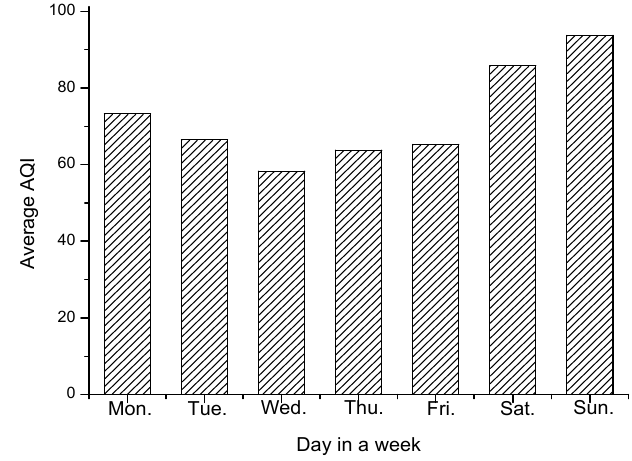
Figure 12. The average AQI within the day in a week.